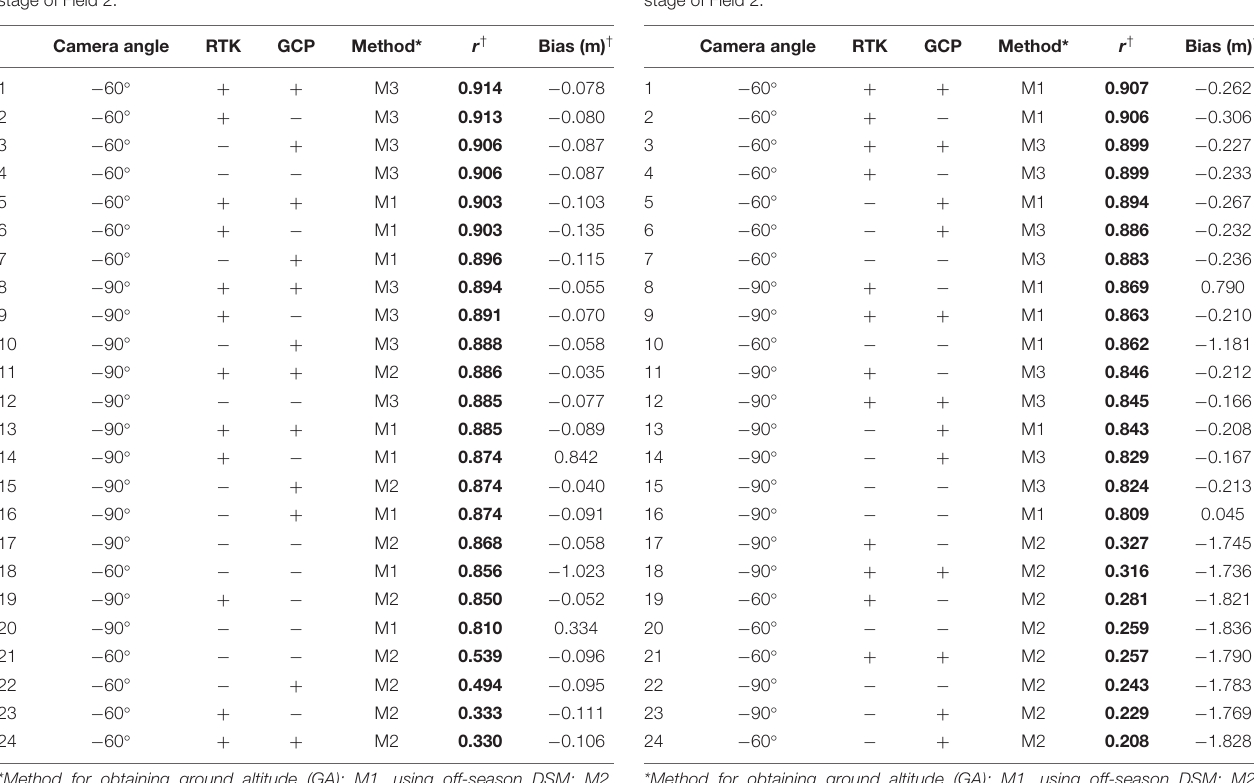
TABLE 6 | Correlation analysis between PH measured and PH SfM in the reproductive stage of Field